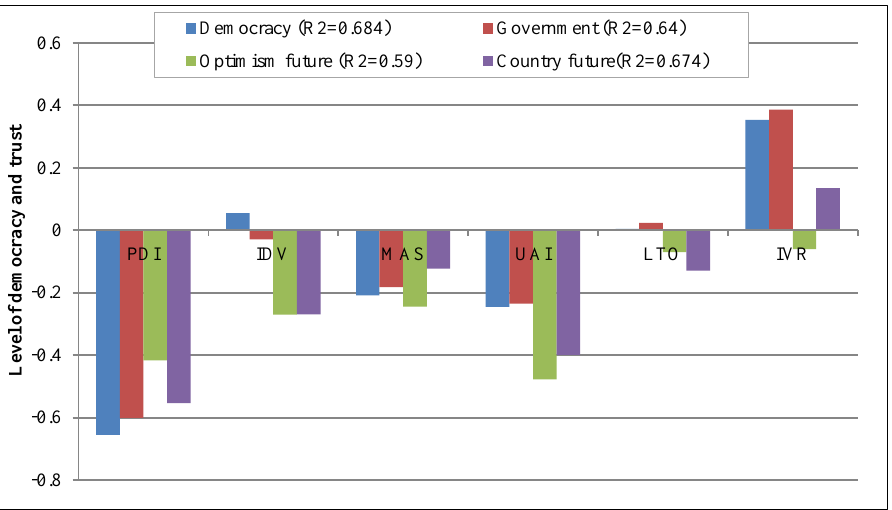
Figure 4. Democracy and trust during